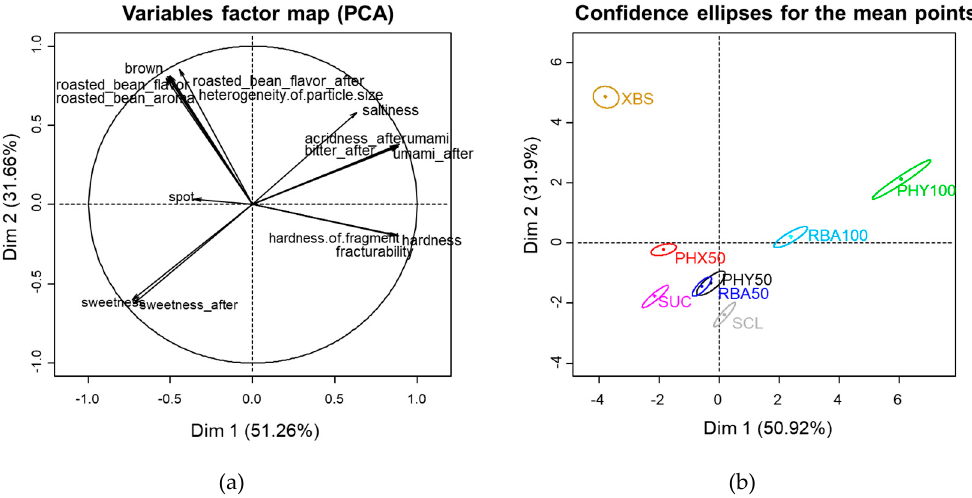
Figure 3. Principal component loading of the sensory attributes ( a ) and sample scores ( b ) from eight sweetener cookies on Dim 1 and Dim 2.